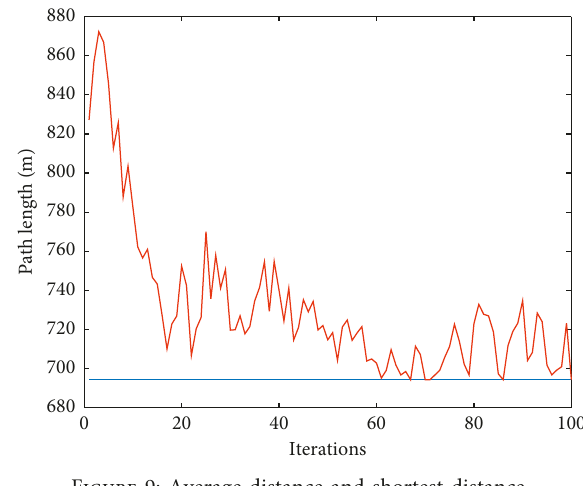
Figure 9: Average distance and shortest distance.